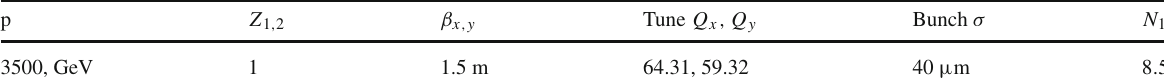
Table 1 Bunch parameters from [24] describing one of van der Meer calibration scans in ATLAS